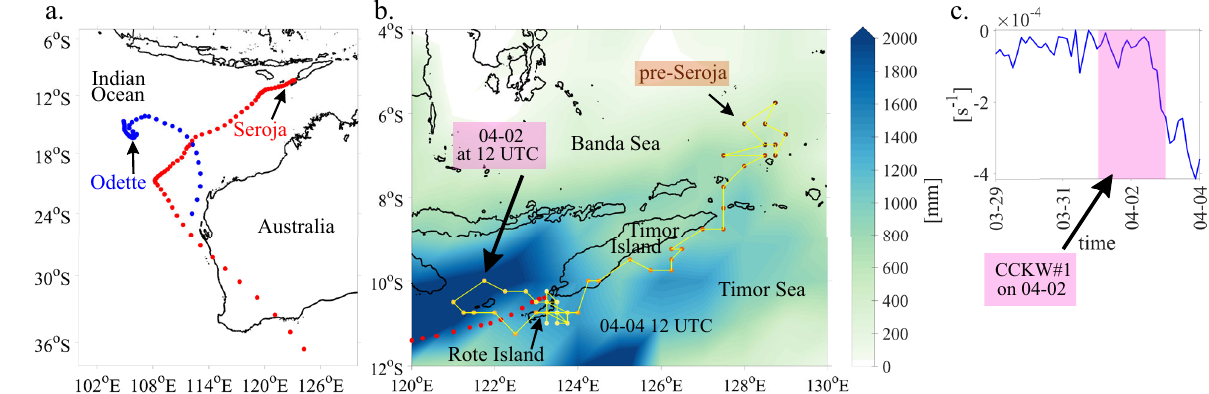
Fig.2|Serojaandpre-Serojatracks.a TropicalCyclone(TC)Seroja(reddots)and TCOdette(bluedots)tracksobtainedfromtheInternationalBestTrackArchivefor Climate Stewardship (IBTrACS). Data every 3h starting on April 4, 12 UTC, b backward trajectory (precursor) of TC Seroja based on ERA-5 relative vorticity (dotted line, data every 3h starting on March 28, 0 UTC) and accumulation of